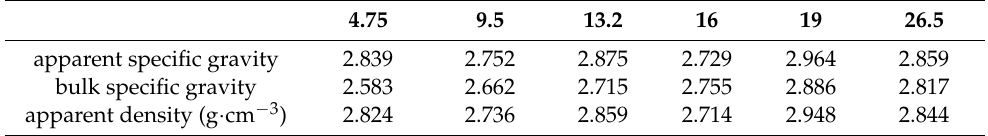
Table 2. Density of coarse